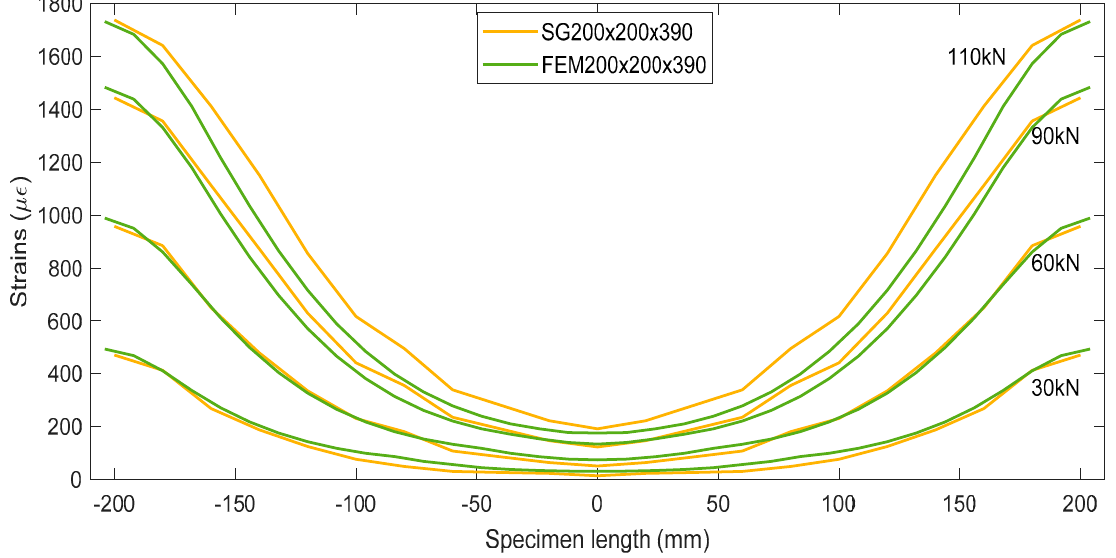
Figure 7. Strain comparison between SG200×200×390 and FEM200×200×390.